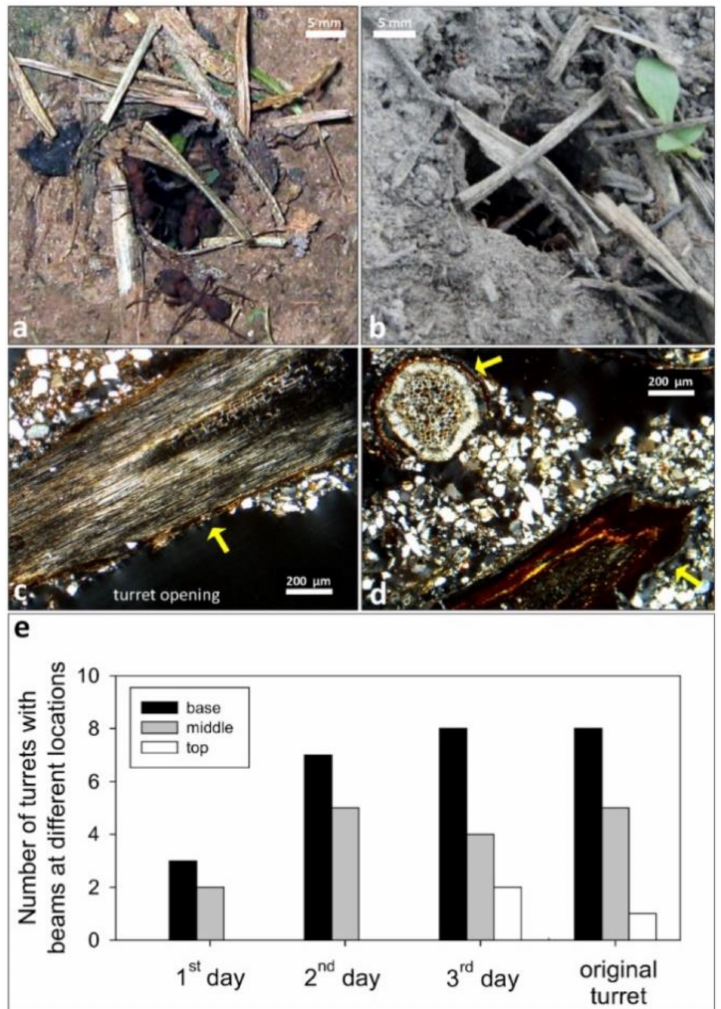
Figure 6. Examples of the occurrence of beams in the turret structure. ( a ) Photo of a nest entrance after removal of the original turret, to show the placement of a beam across the opening. ( b ) An additional example showing the position of the two first beams carried and placed by ants on the free nest entrance. ( c , d ) Two thin sections of di ff erent turret walls to illustrate the occurrence of beams—yellow arrows—embedded in the turret wall. In ( c ), the large beam was facing the turret opening and partially coated with sand grains and clay aggregates. ( e ) Occurrence of beams at di ff erent locations in the structure of the turrets rebuilt over three days, as compared to the original turrets. No attempt was made to perform statistical comparisons of the counts, because of the low sample size ( n = 10 turrets analyzed in each group). Photo credits: ( a ): D. Römer; ( b ): F. Roces; ( c , d ): M. I.